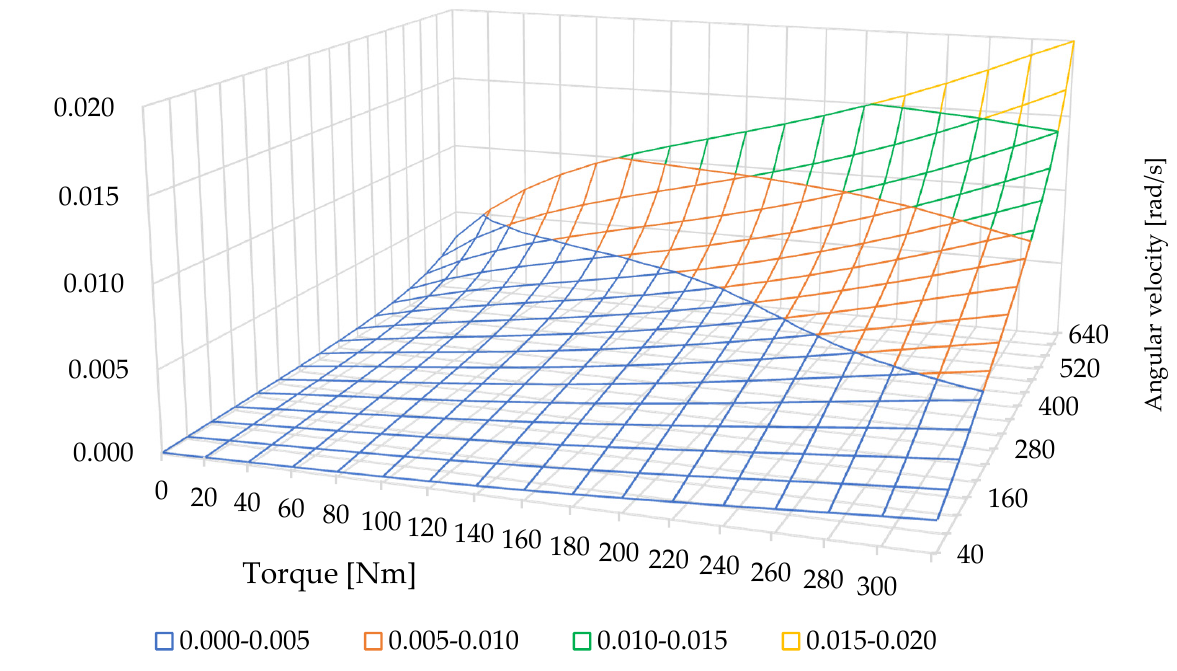
Figure 9. Waveform of the instantaneous values of the fuel stream consumed by the engine as a function of the engine crankshaft angular velocity and torque generated at the engine crankshaft [75]. Table 3. Basic parameters of fuels used in the simulation (Fuel used in EPA tests) [87–91].